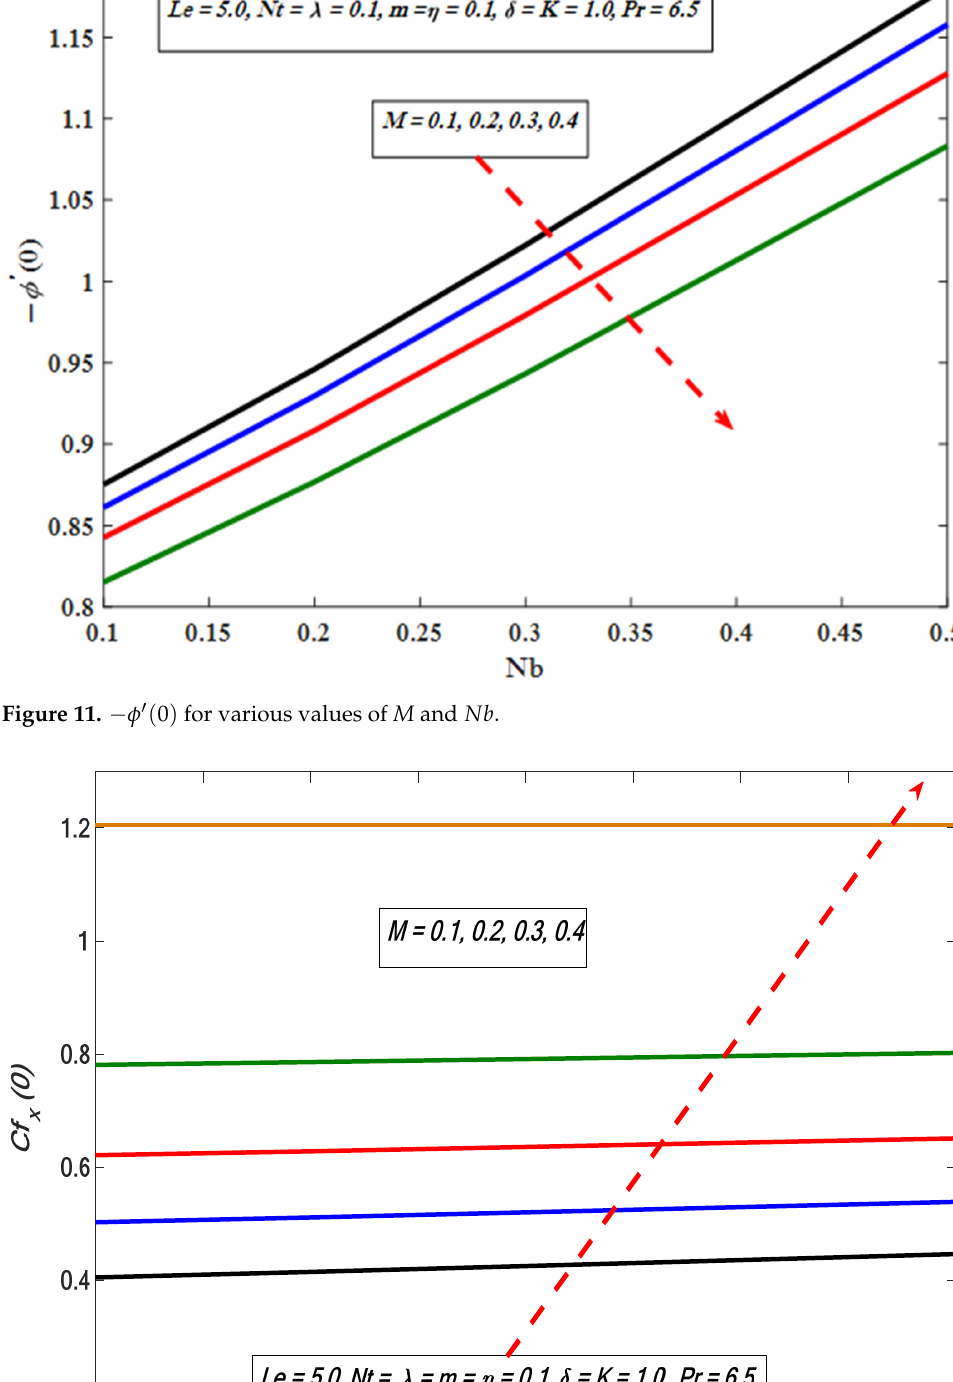
Figure 10. (cid:3398)𝜃′(cid:4666)0(cid:4667) for various values of M and 𝑁𝑏.